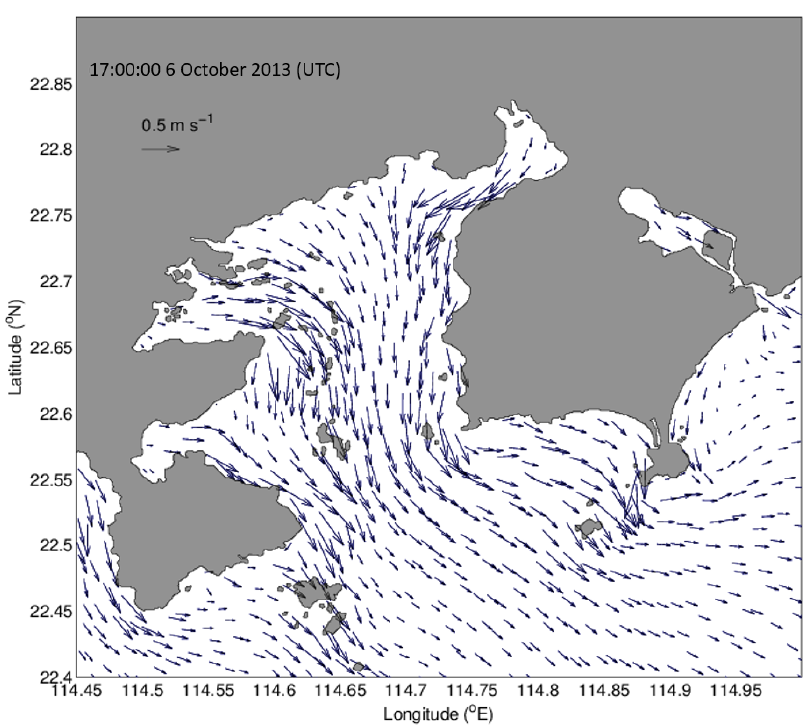
Figure 4. The tidal current in the experimental area at 17:00:00 6 October 2013 (UTC) was predicted using the FVCOM. It is in an ebb tidal course, in which seawater flows out of Daya Bay.